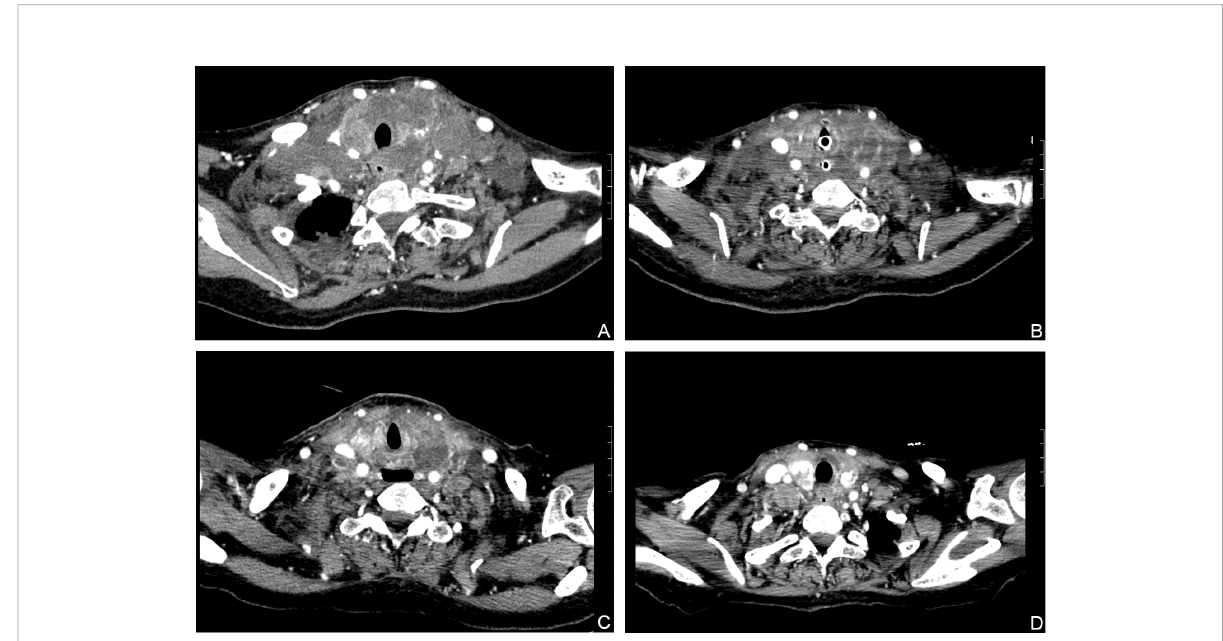
FIGURE 1 Hematoxylin and eosin (HE) stained FNAB of thyroid lobe (A) , 20× magni fi cation) revealed malignant epithelial cells. IHC staining showed that malignant cells in thyroid were positive for G-3 (B) , 20× magni fi cation), and negative for TTF1 (C) , 20× magni fi cation), TG (D) , 20× magni fi